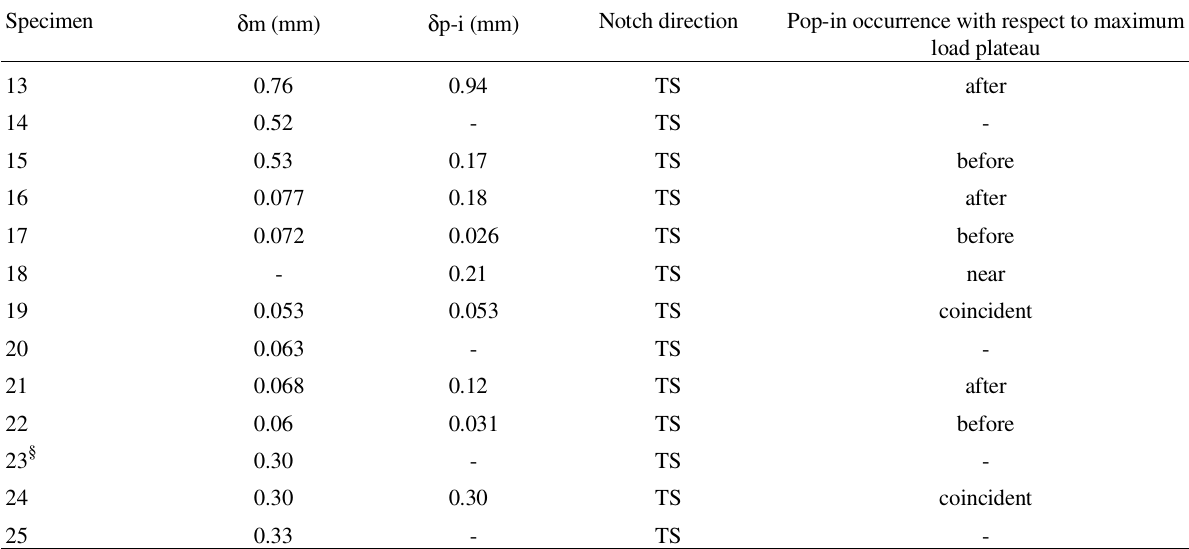
Table 4. CTOD values at maximum load and at pop-in initiation. TS specimens.